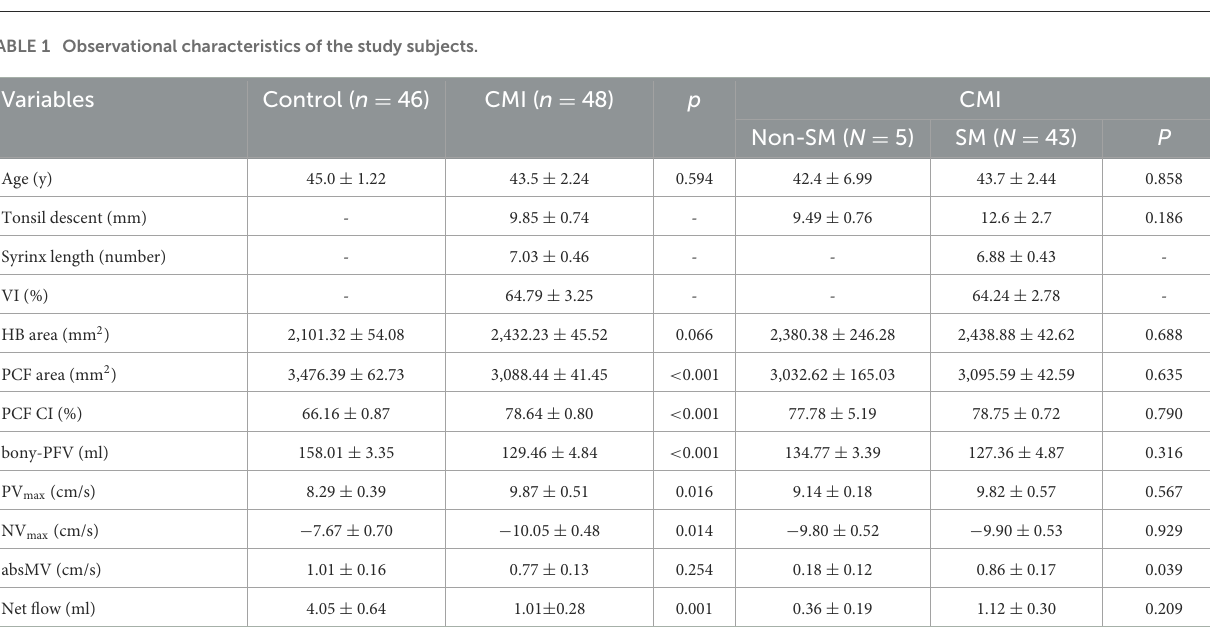
FIGURE2 Region of interest of CSF (A, B) . The blue line represents McRae’s line, and the blue area is the cross-sectional area of CSF at CVJ. CSF time–velocity curve in one cardiac cycle (C) .